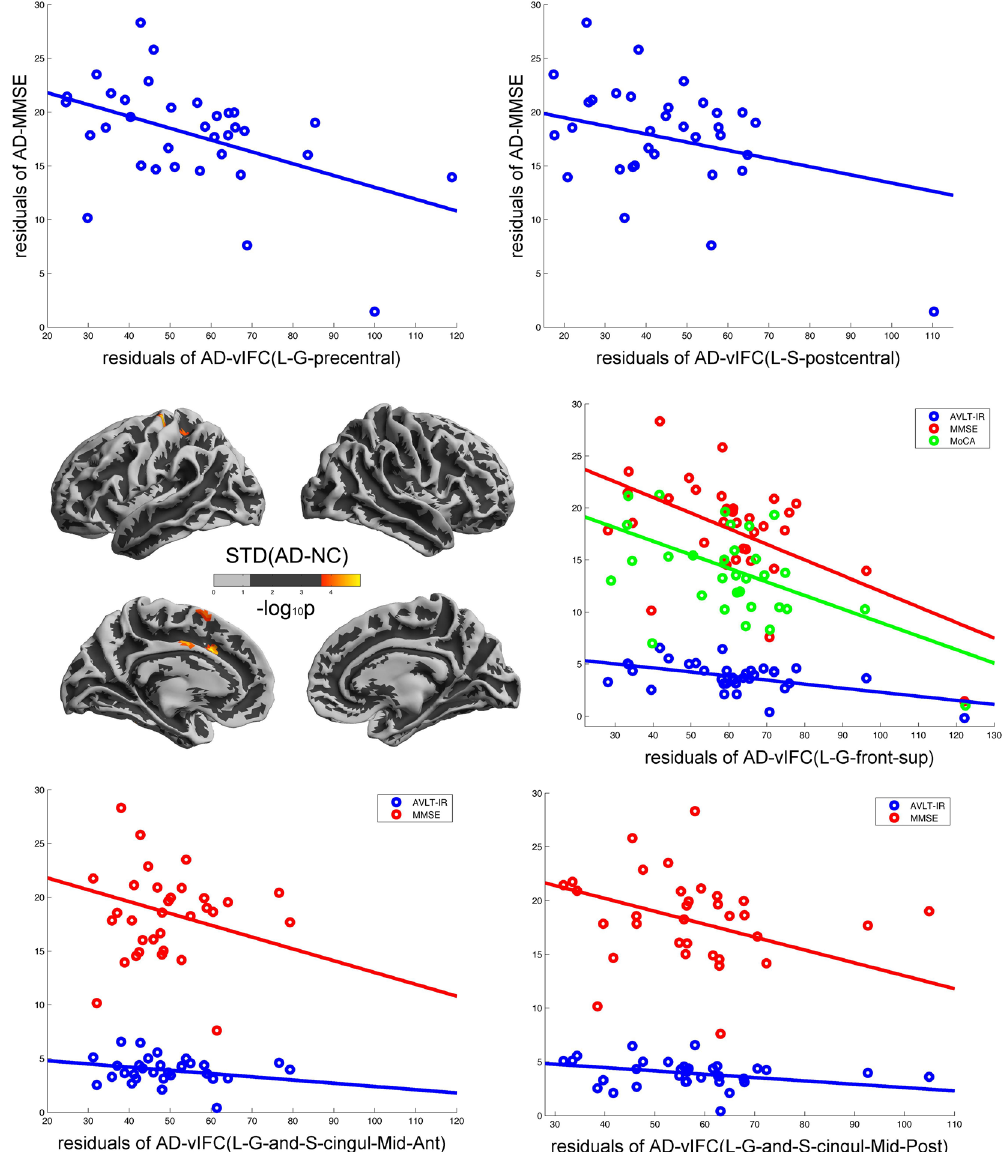
Figure 4. Significant AD-NC differences in STD across cortical mantle. The warm color stand for significant increased STD compared to normal controls (FDR α < 0.05/2, corrected p < 0.05/2). The five scatters represent the significant negative correlations of STD with behavioral